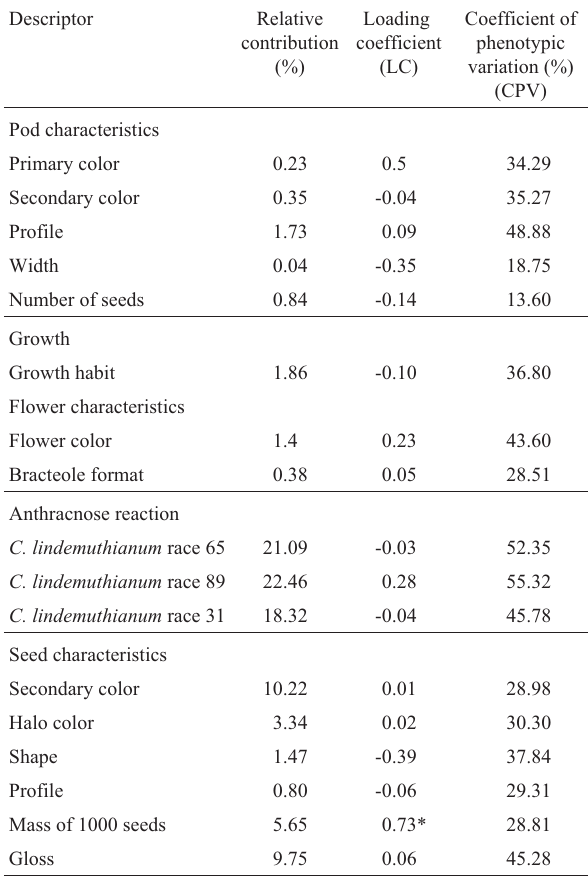
Table 2 - Relative contribution (%) of the descriptors to the multivariate divergence, loading coefficients (LC) of the eigenvectors of the last prin- cipal component, and coefficient of phenotypic variation (CPV) of each